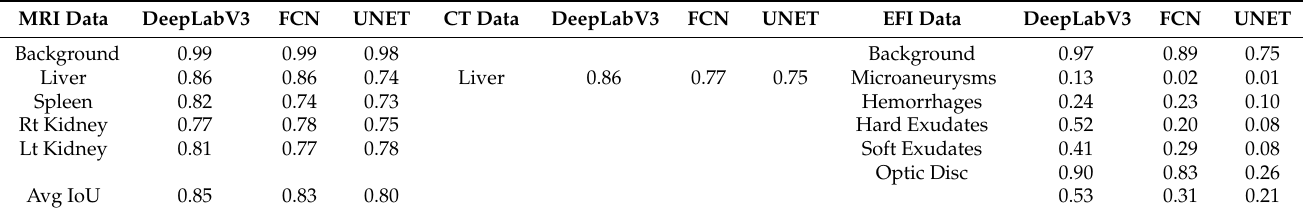
Table 1. Intersect-over-the-union (IoU) of segmentation networks with base crossE loss (MRI, CT and EFI).